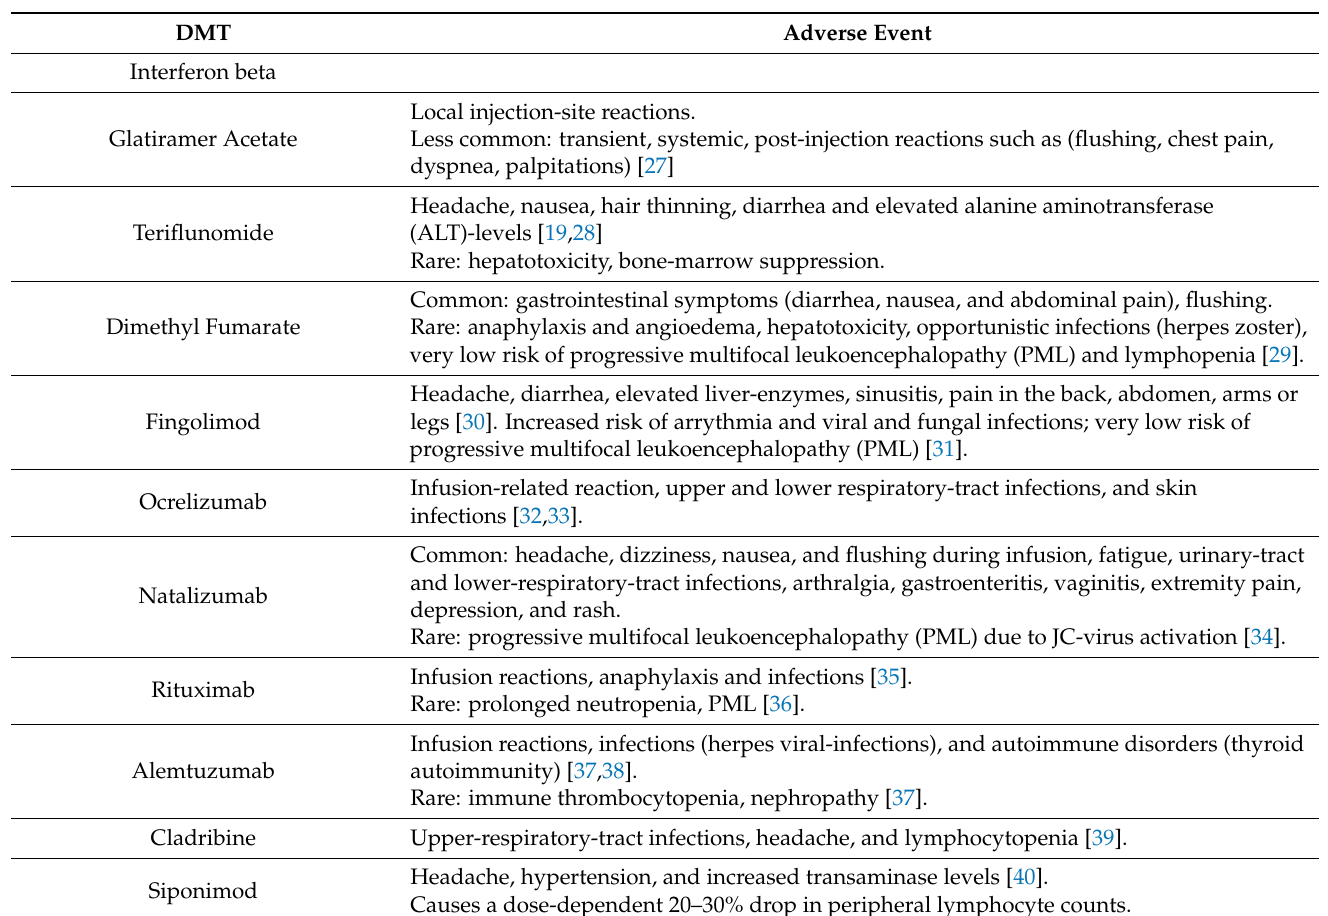
Table 5. Disease-modifying therapy (DMT)-specific and adverse events. DMT Adverse Event Interferon